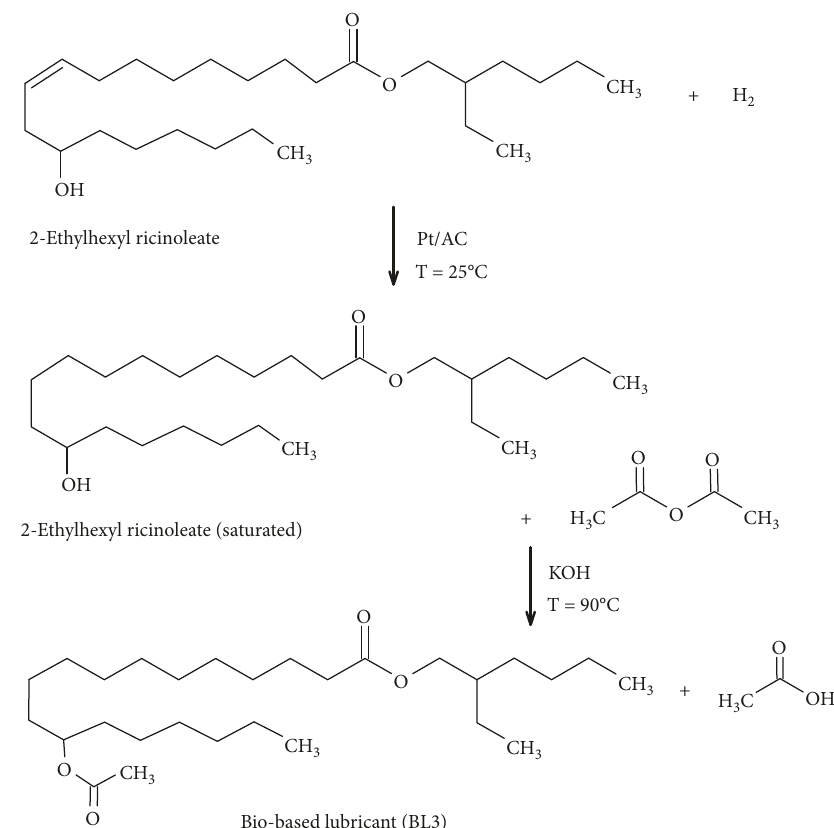
Figure 4: Synthetic route for the bio-based lubricant